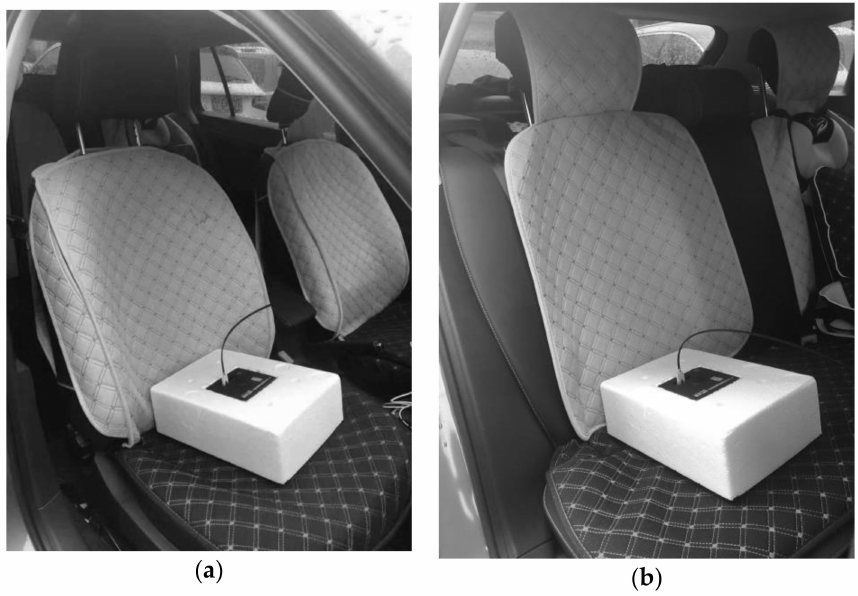
Figure 1. Positioning of the extremely low frequency (ELF) magnetic field (MF) probes at the right front ( a ) and rear ( b )